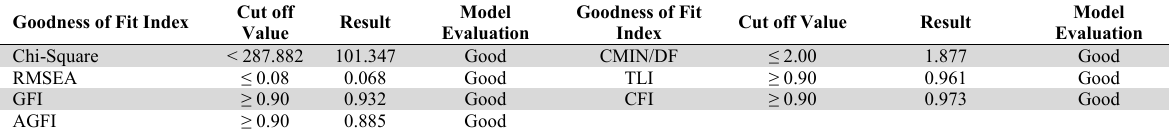
Table 2 Model Measurement Feasibility Test Results Goodness of Fit